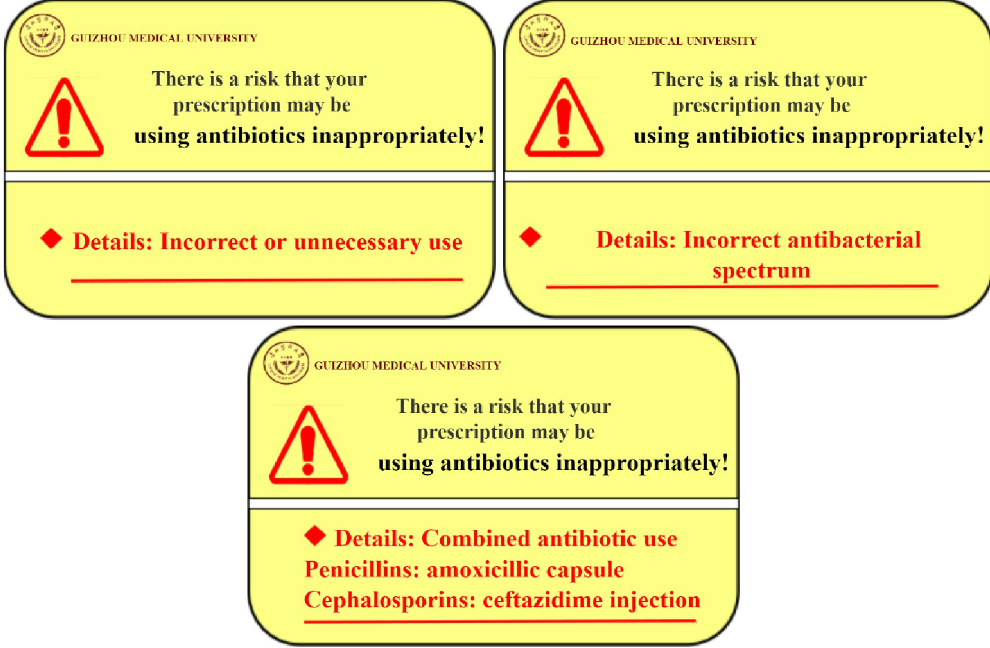
Fig 3. Example of unreasonable use of antibiotic warning